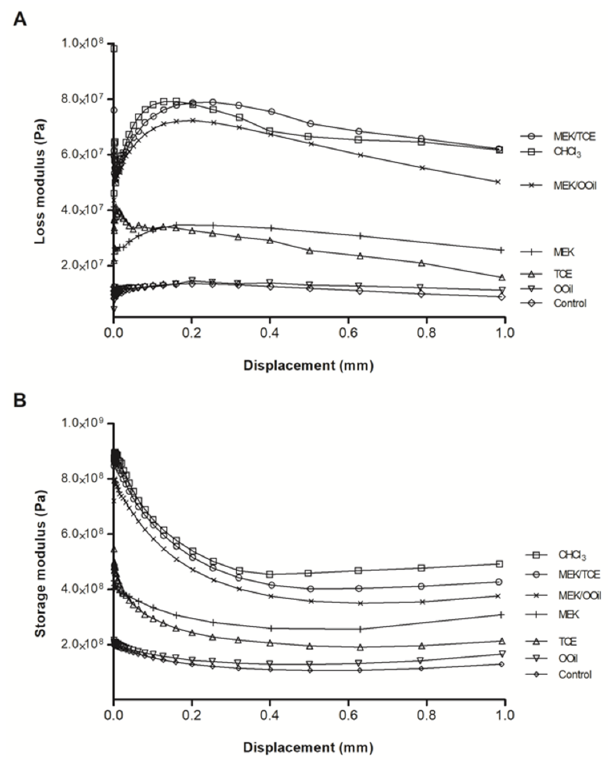
Figure 4. The storage modulus ( A ) and loss modulus ( B ) of the gutta-percha samples after immersion in the tested solutions for 5 min—control (samples not exposed to the solvents); CHCl 3 , chloroform; MEK, methyl ethyl ketone; TCE, tetrachloroethylene; OOil, orange oil. Mixtures: MEK/TCE; MEK/OOil.